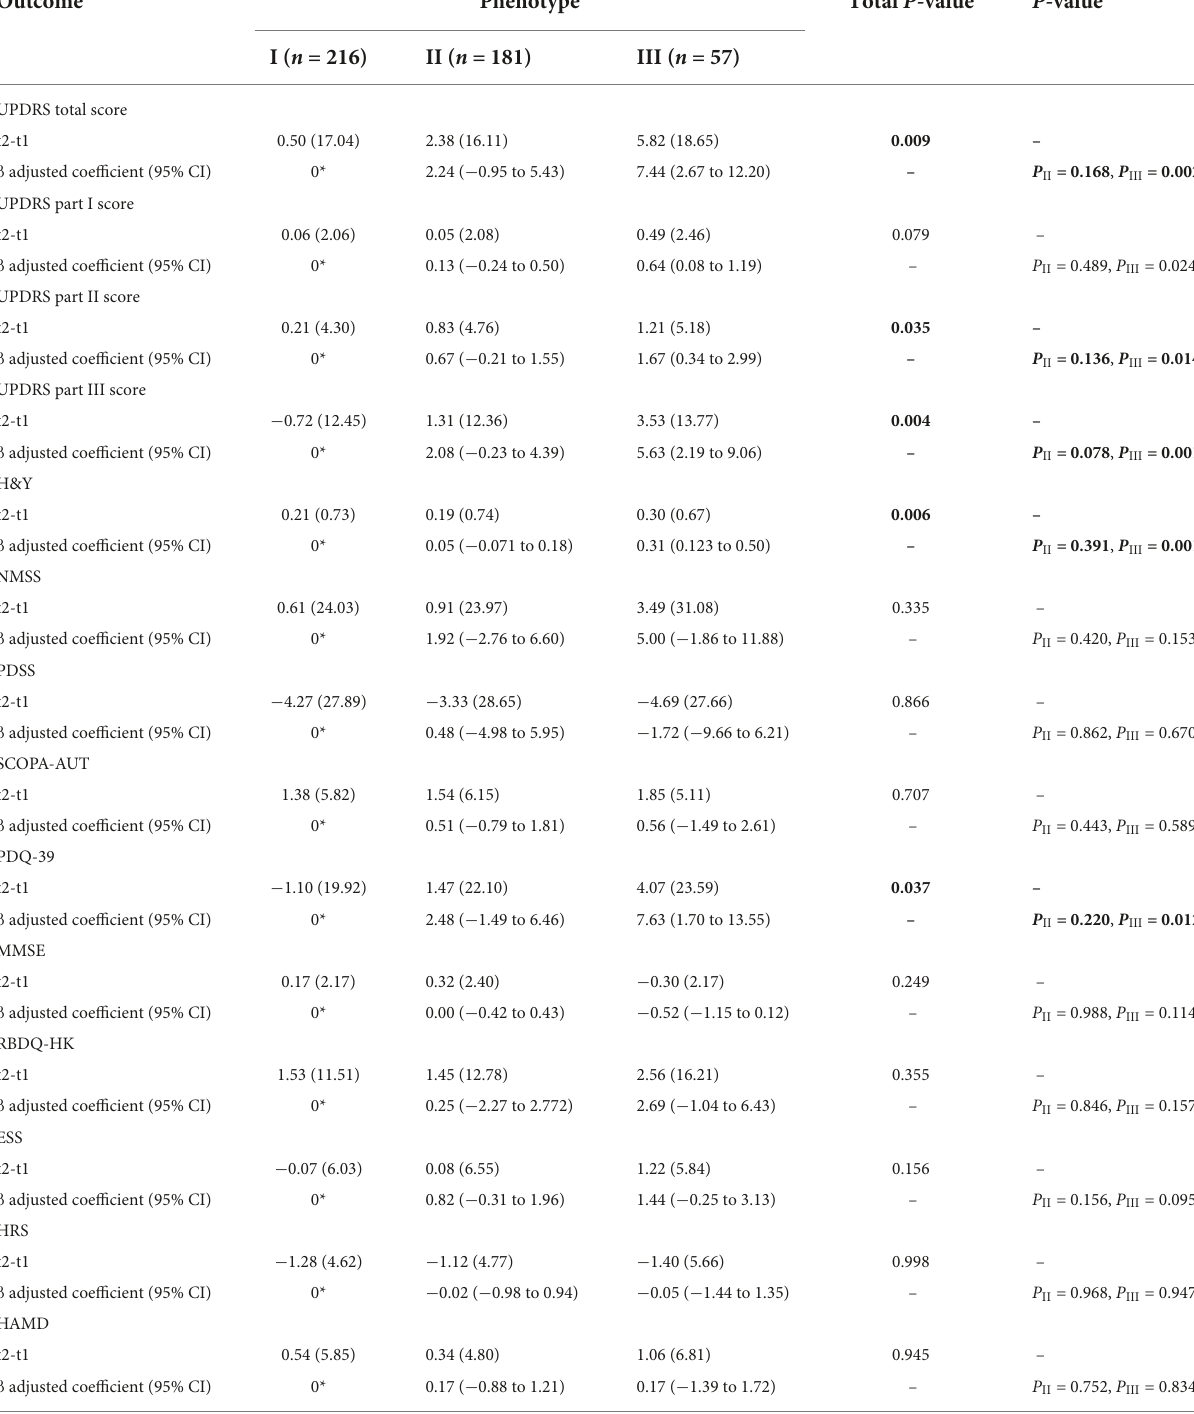
TABLE 2 Longitudinal changes in clinical motor and non-motor outcomes in three different clinical phenotypes of EOPD at follow-up. Outcome